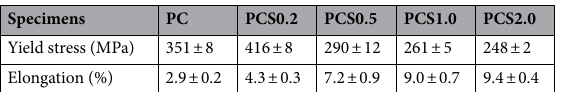
Table 1. Yield stresses and elongations of various Cu electroplated samples.